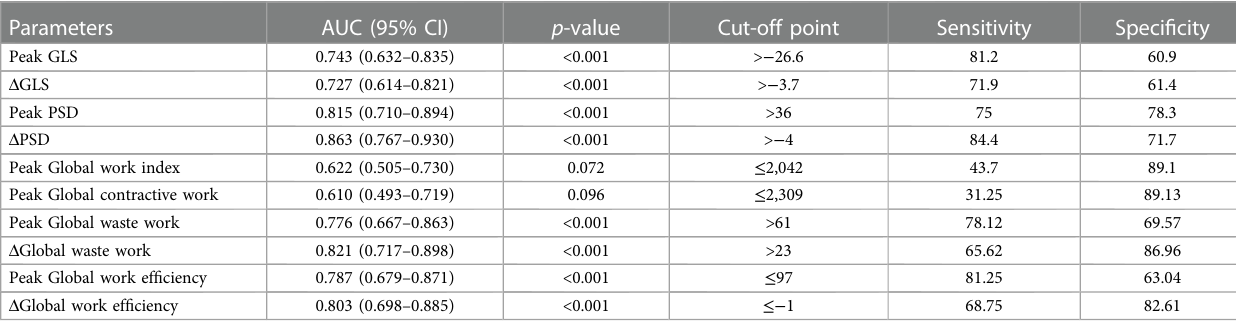
TABLE 5 ROC curve analysis for the detection of